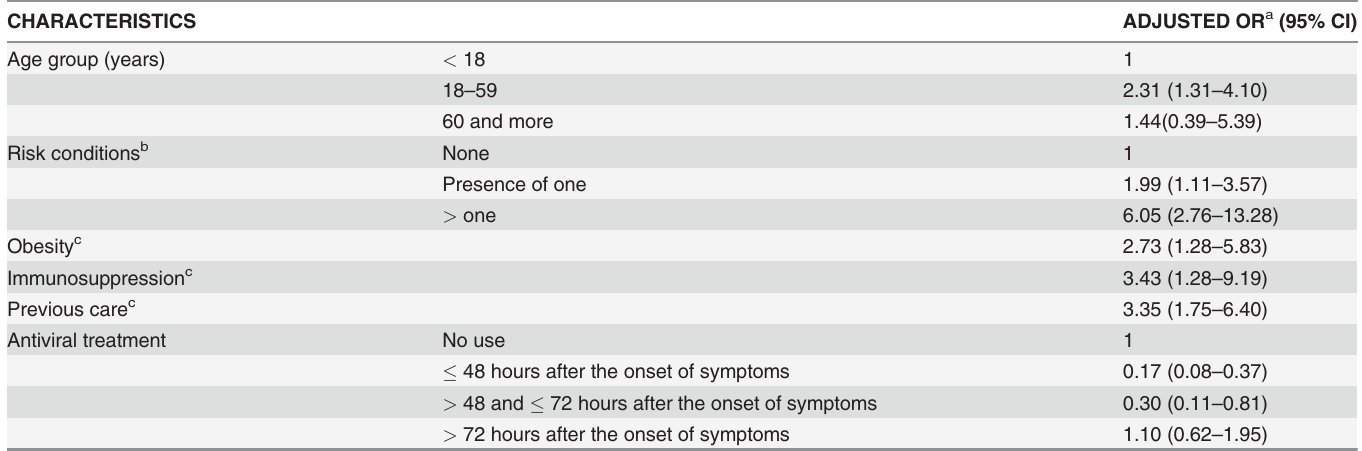
Table 4. Risk factors for death from in fl uenza A(H1N1)pdm09 associated with Severe Acute Respiratory Illness, metropolitan regions of S ã o Paulo and Campinas, state of S ã o Paulo, Brazil, 2009.